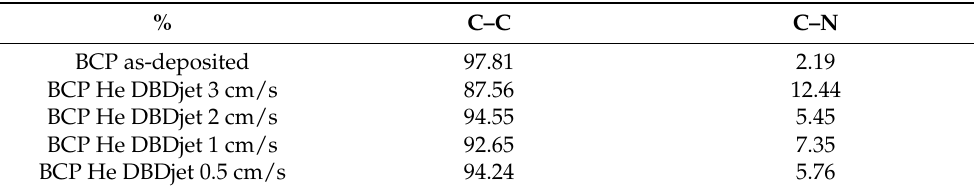
Figure 3. Structure of BCP. Table 1. XPS deconvolution results for C1s spectra of the BCP